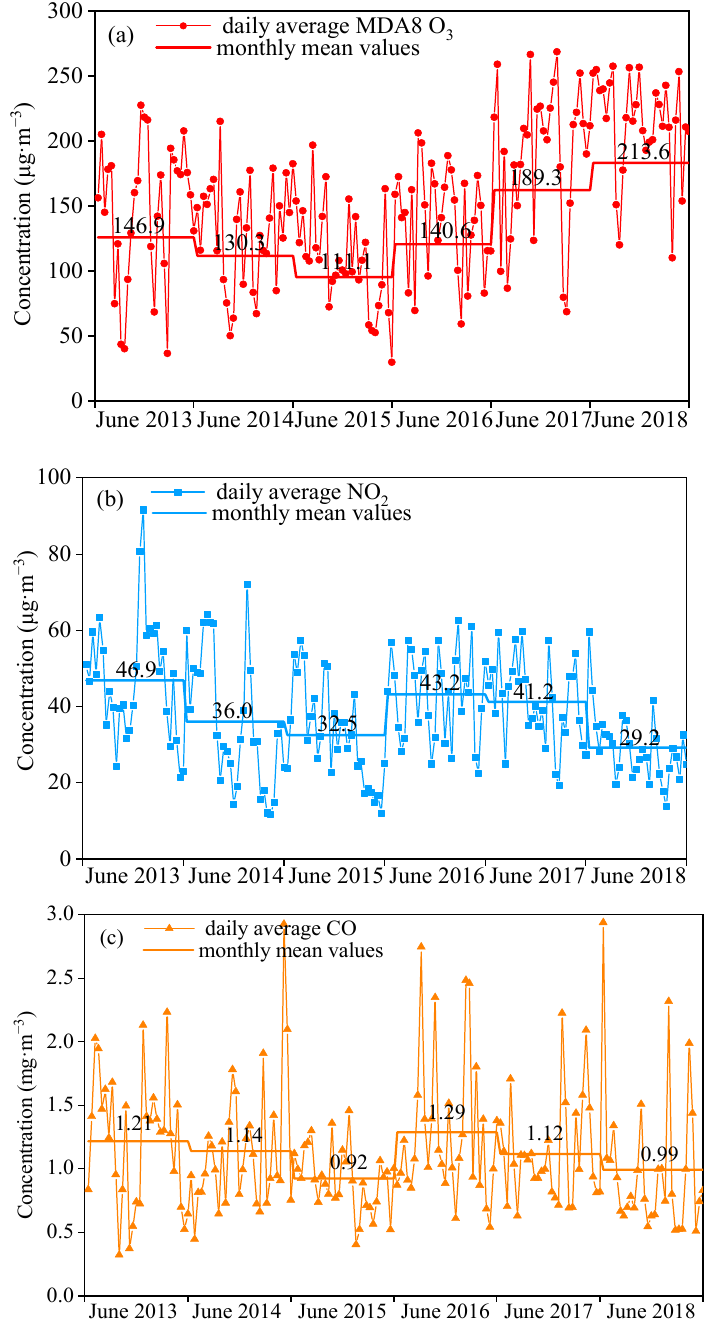
Figure 3. Change in the June average ambient concentrations of ( a ) O 3 , ( b ) NO 2 , and ( c ) CO across downtown Handan from June 2013–2018.